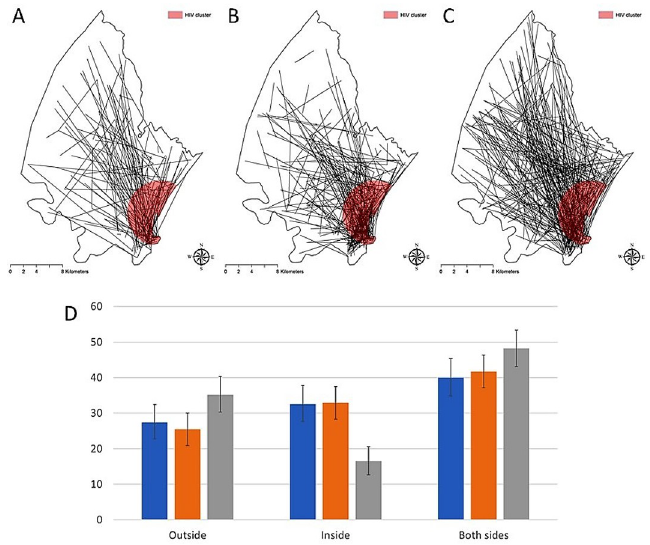
Fig 5. Comparisons among link estimations derived from the microsimulation models. A) Spatial distribution of the HIV transmission links from the data. B) Spatial distribution of the HIV transmission links using the gravity model C) spatial distribution of the HIV transmission links using the random model. D) Comparisons between the percentage of HIV transmission links from individuals located outside, individuals located inside, and links formed by one individual located inside and the other individual located outside of the HIV high-risk area. Blue bars illustrate the estimations from the data, orange bars illustrate estimations from the gravity model, and blue bars illustrate estimations from the random model. Spatial random error in the geographical references of all linkages of viral transmission identified was introduced, and thus does not represent the actual spatial location of the links, and maps were generated for illustrative purposes only. Maps were created using ArcGIS by Esri version 10.5 (http://www.esri. com) [39].